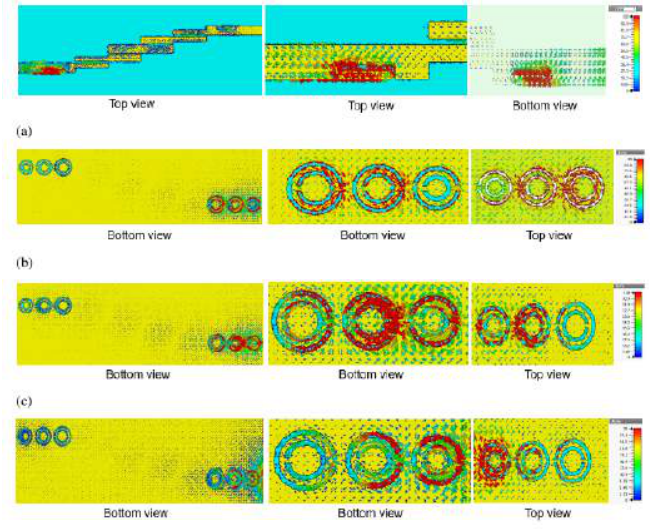
Figure 11: Current distribution of the proposed filters at : (a): 11 : 56 GHz , (b): 8 : 75 GHz , (c): 9 : 34 GHz and (d): 10 : 17 GHz